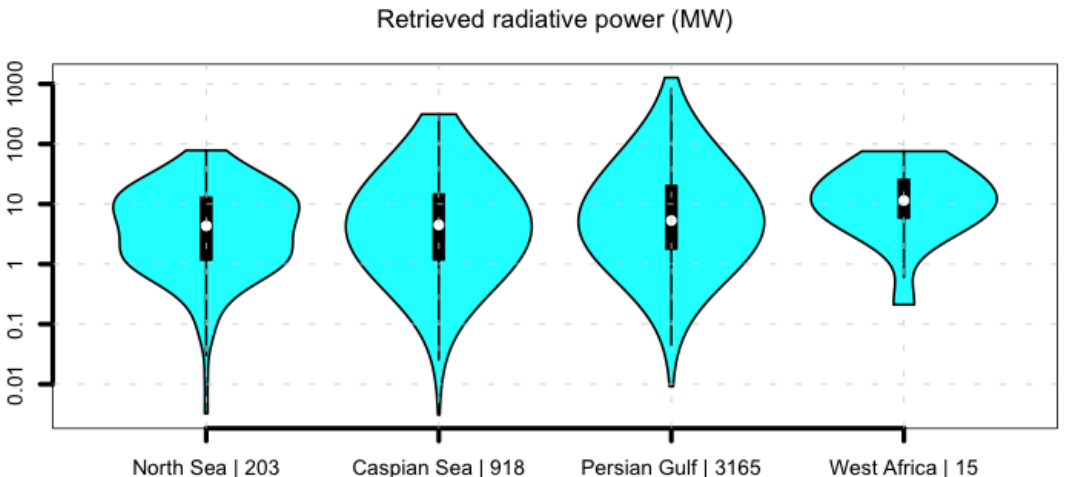
Figure 13. Violin plots for the temperature, area and the radiative power retrieval distributions of the high-accuracy persistent hot spots. The number of high-accuracy persistent hot spots is also